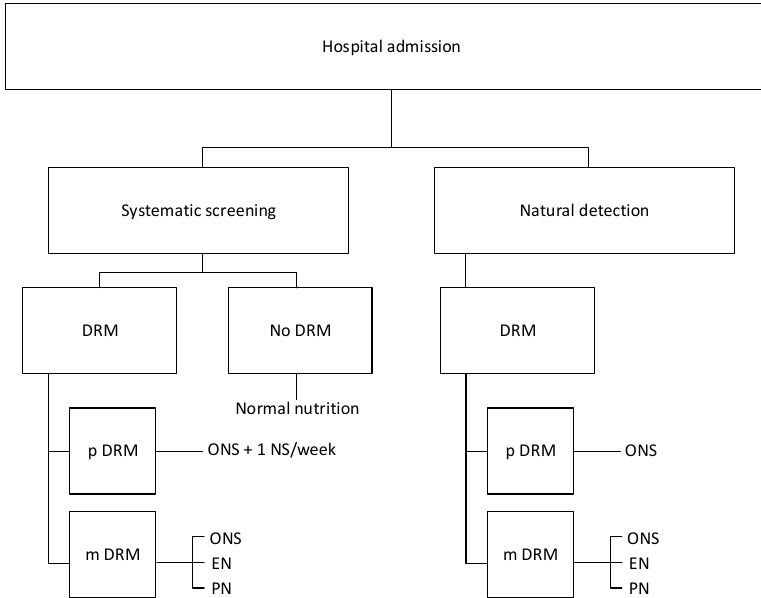
Figure 1. Nutritional screening (NS) and natural detection (ND). DRM: Disease-related malnutrition;